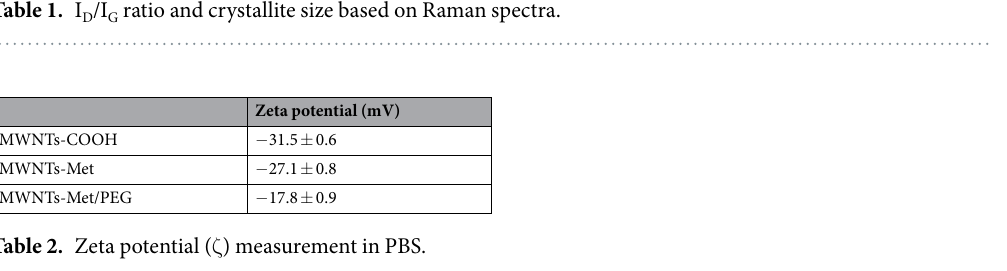
Table 1. I D /I G ratio and crystallite size based on Raman spectra.